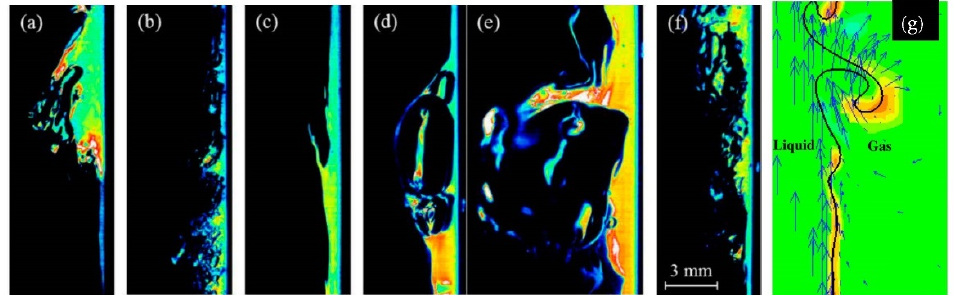
Figure 15. PLIF images showing the droplet entrainment process: ( a ) disturbance wave, ( b ) wave undercut ( c ) ligament break-up, ( d , e ) different stages of a bubble burst, ( f ) liquid impingement, adapted with permission from [48], 2014, Elsevier and ( g ) simulation of the droplet formation of undercutting zone, adapted with permission from [231], 2016, Elsevier.